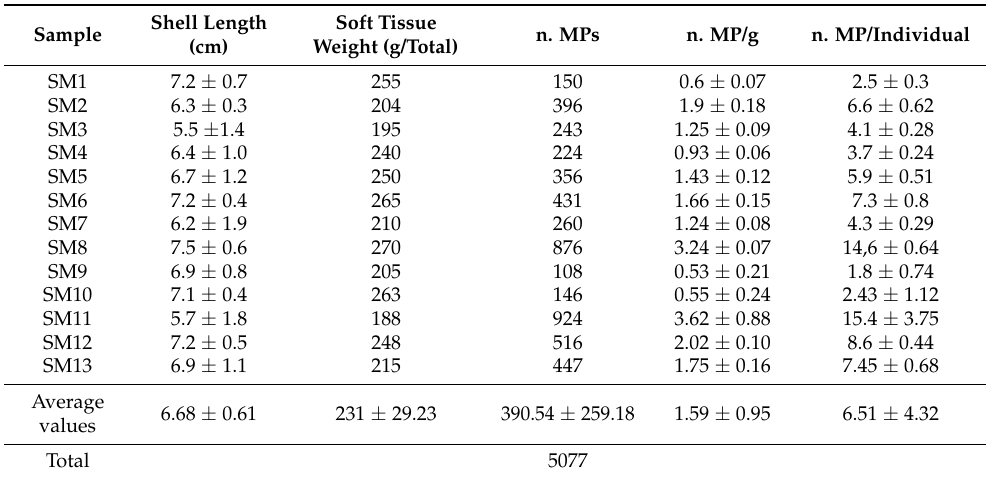
Table 1. Average values of MPs in the three repetitions for each mussel sample. Shell Length Soft Tissue Sample (cm) Weight